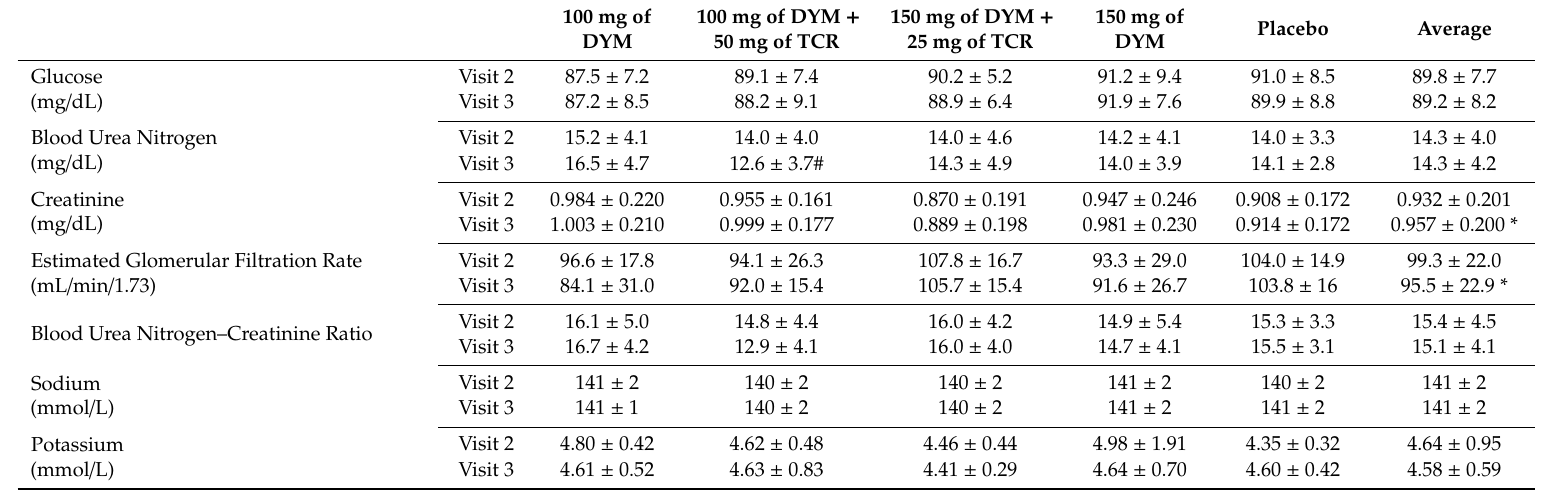
Table 5. Group ( n = 25 per group) and average complete metabolic panel comparisons between Visits 2 and